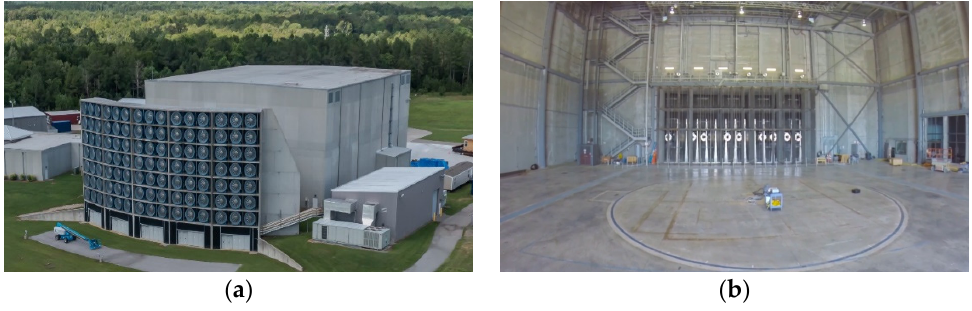
Figure 3. ( a ) The IBHS Research Center and ( b ) inside the test chamber.